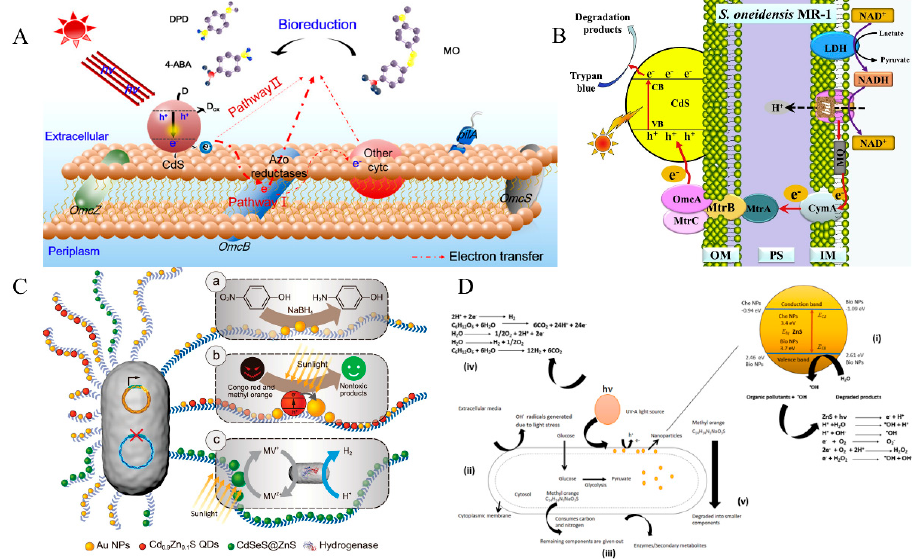
Figure 5. ( A ) Schematic illustration of the degradation pathway of MO using the CdS– G. sulfurre-